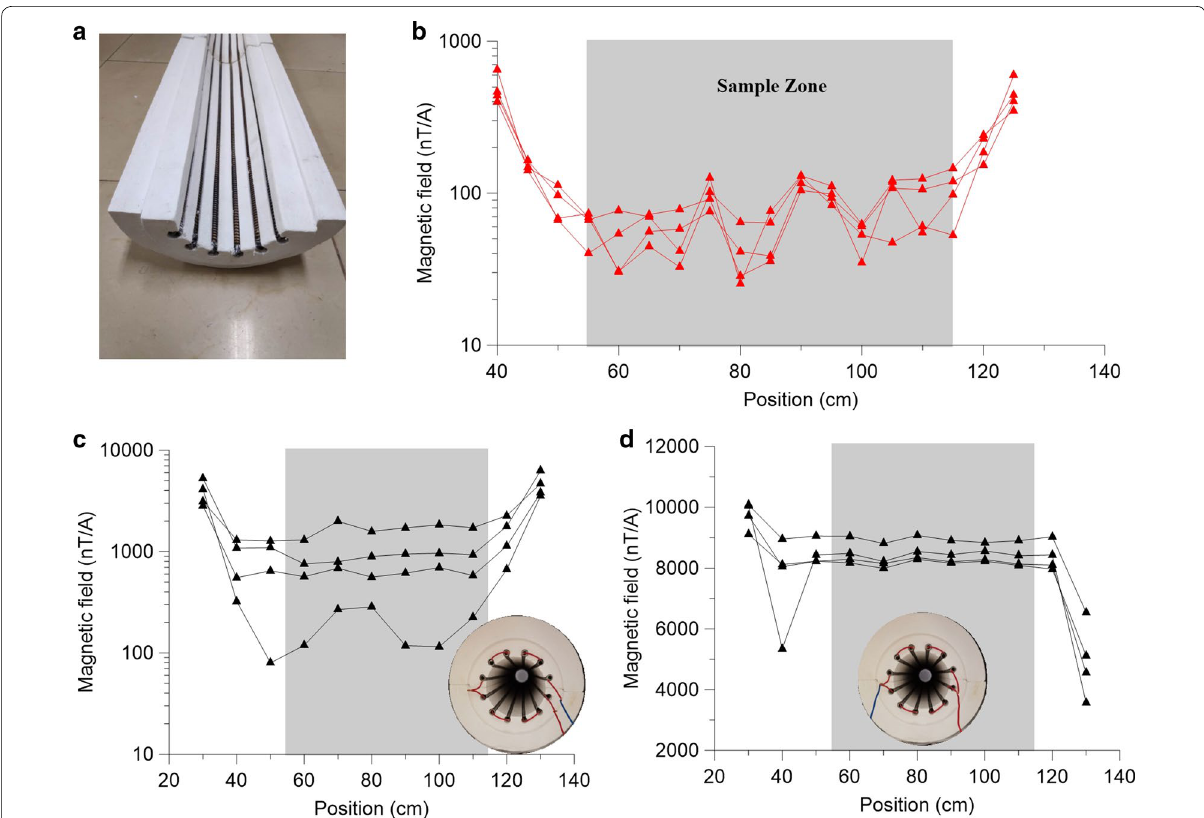
Fig. 7 a Photo of the new furnace chamber. b Current field (red triangles) with 1 A applied to the heating wire along longitude axis in the newly designed furnace (multiple curves represent different vertical distances from the central axis). c Current field with 1 A applied to the heating wire along longitude axis in conventional furnace, the current of adjacent solenoids is opposite. d Current field with 1 A applied to the heating wire along longitude axis in conventional furnace, currents of adjacent solenoids in each group are opposite, but two groups in parallel connect